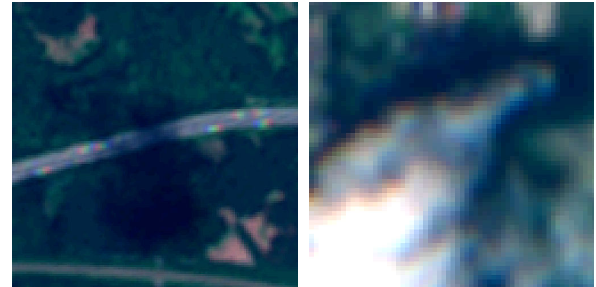
Figure 1. Examples from a Sentinel-2 image, left: color shifts due to moving cars, right: color shifts due to non-ground objects (clouds), sections 2 . 5 × 2 . 5 km 2